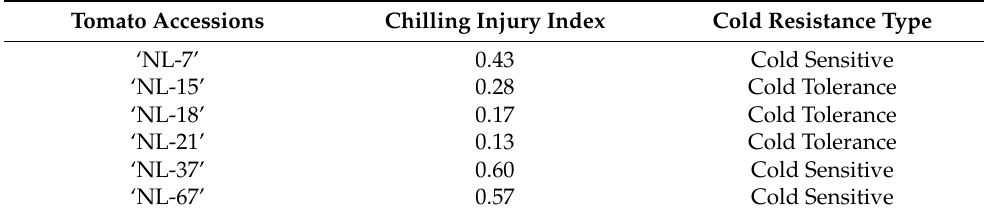
Figure 1. Tomato plant phenotypes with different levels of chilling injury index after 15 days of low temperature treatment. Table 2. The chilling injury index and chilling injury type of tomato.